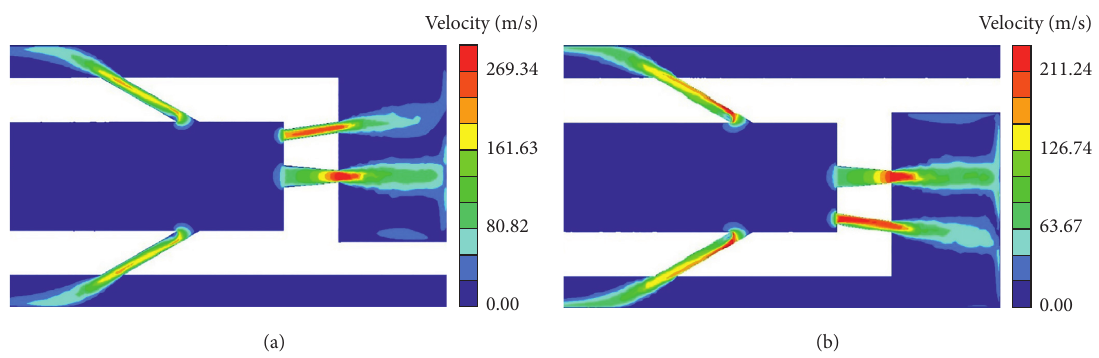
Figure 4: Velocity cloud diagram of cross section of two kinds of fluid in the center axis of the jet bit.